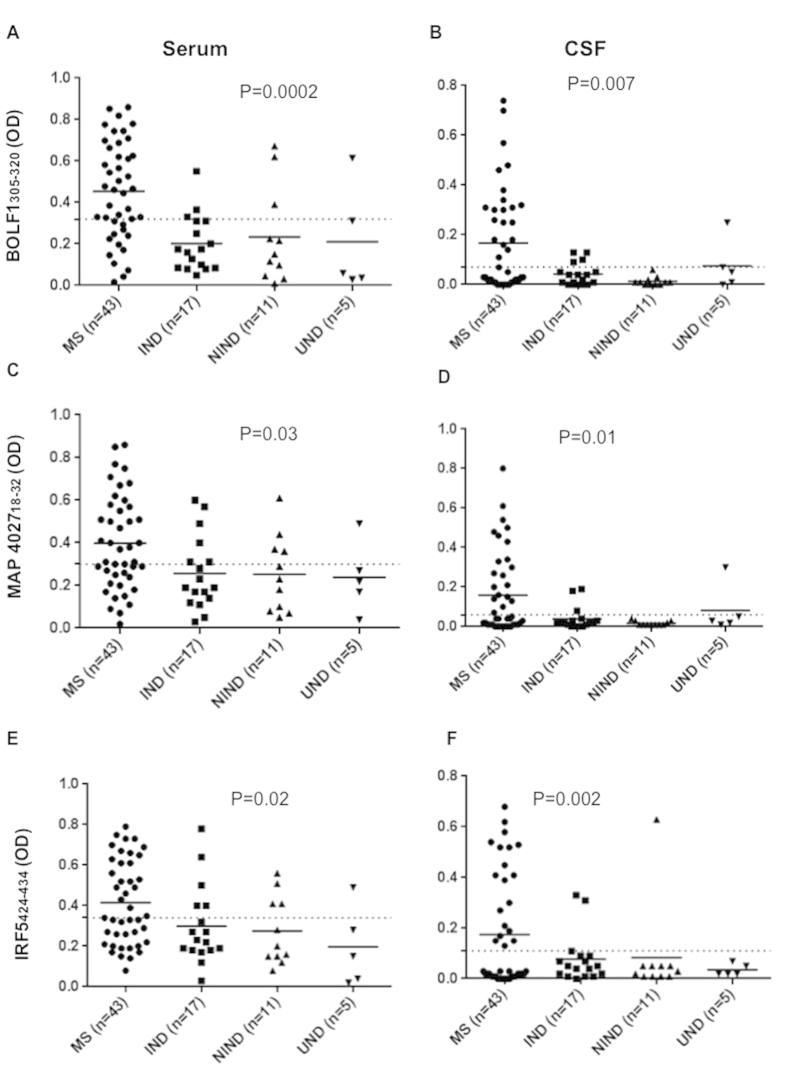
Antibody OD measured by indirect ELISA.Forty-three patients, seventeen IND, eleven NIND and 5 UND were tested for their reactivity against plate-coated with BOLF1305–320, MAP_402718–32 and IRF5424–434 in serum (A,C,E) and in CSF (B,D,F). The horizontal black bars represent the mean value, while p values are indicated by two headed arrows drown on the top of each distribution. Cut-off values for positivity, calculated by ROC analysis, are indicated by dashed lines.